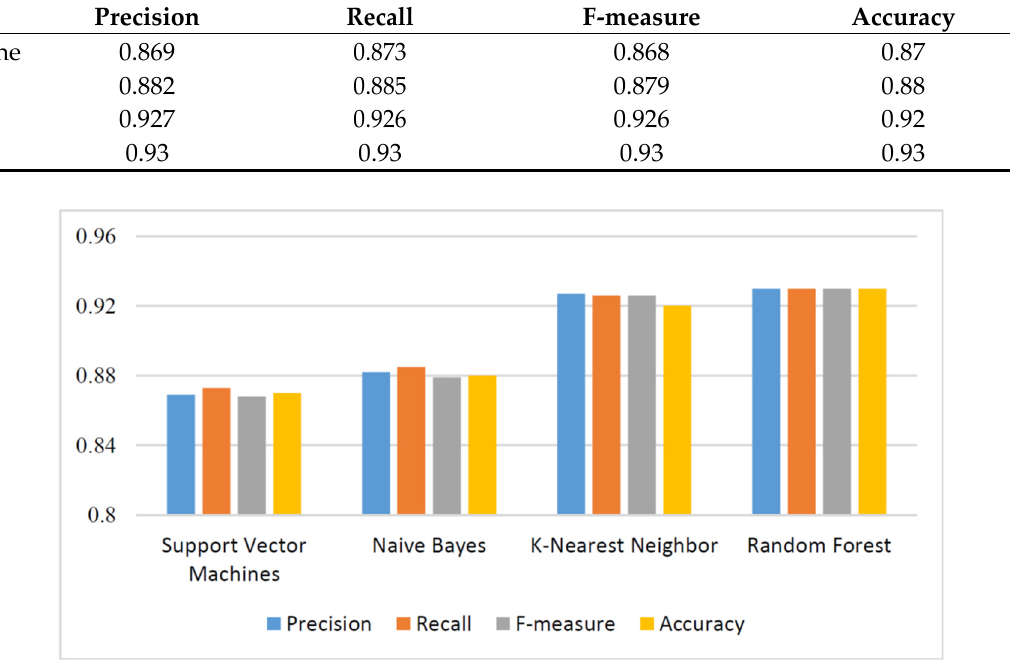
Figure 2. Evaluation of machine learning